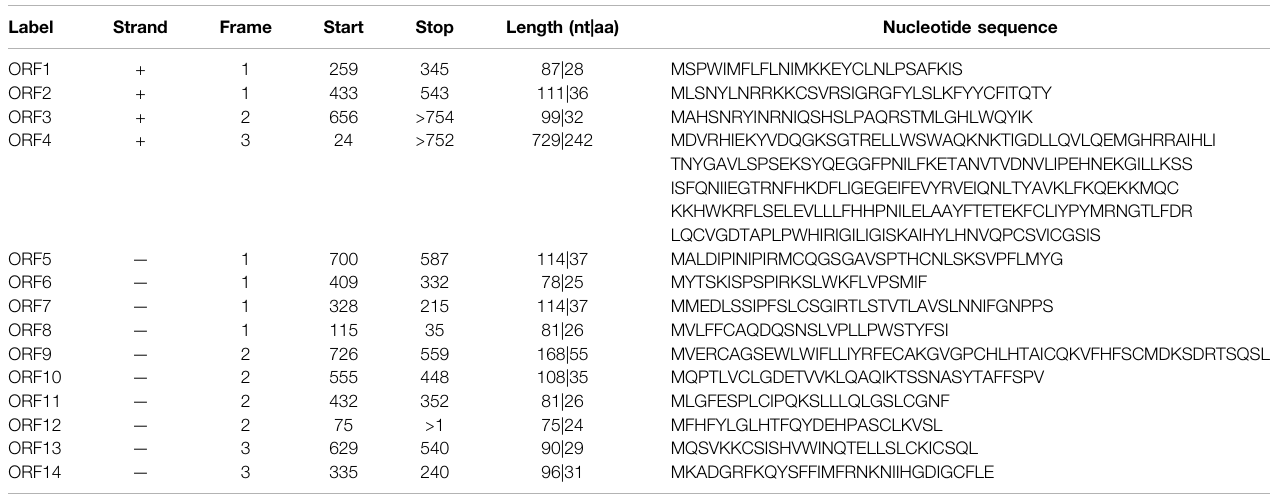
TABLE 1 | Open reading frames that detected from